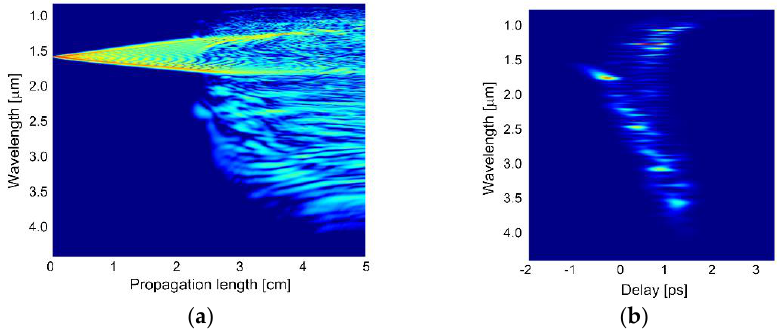
Figure 13. ( a ) Evolution of the pulse and ( b ) spectrogram for the dispersion-optimized PCF.